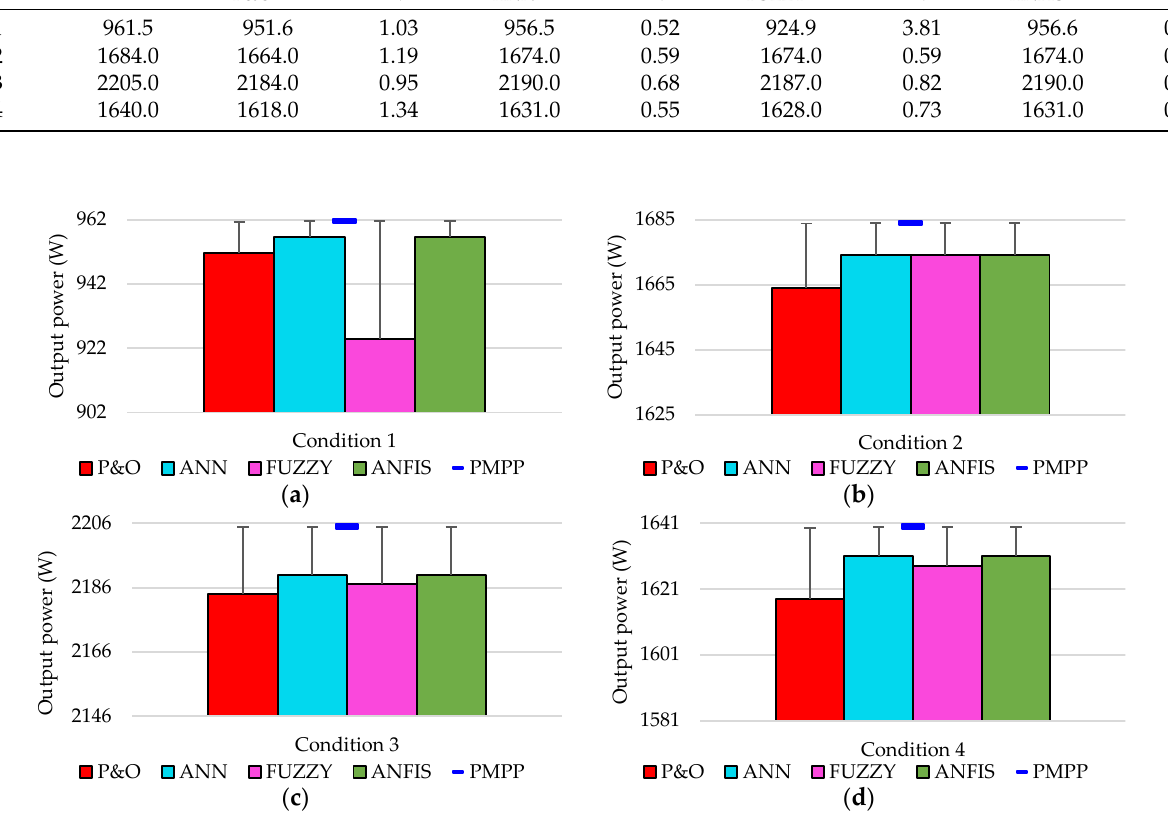
Figure 12. The average power of the PV system in the steady state and their respective error bars for ( a ) Condition 1, ( b ) Condition 2, ( c ) Condition 3, and ( d ) Condition 4.